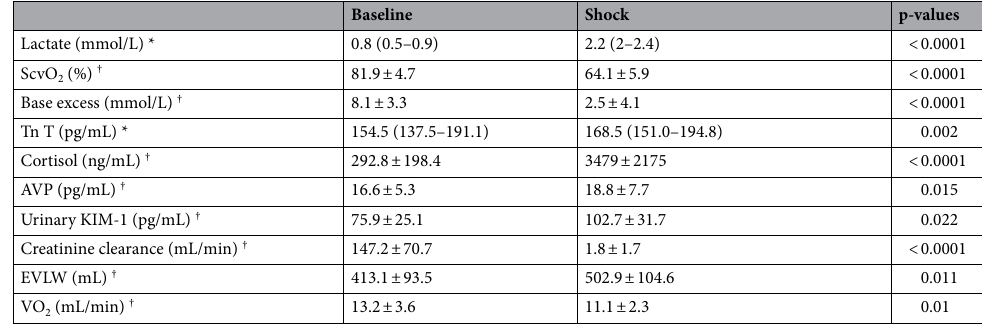
Table 1. Additional main biological parameters before and after FP-induced shock in sheep. All data are expressed as the median [25–75 interquartile range] ⁎ or mean ± SD † , as appropriate, for n = 18 sheep. Variation was compared with a paired t -test or the Mann Whitney U test. ScvO 2 central venous oxygen saturation, Tn T troponin T, AVP arginine vasopressin, KIM-1 kidney injury molecule-1, EVLW extravascular lung water, VO 2 oxygen consumption.